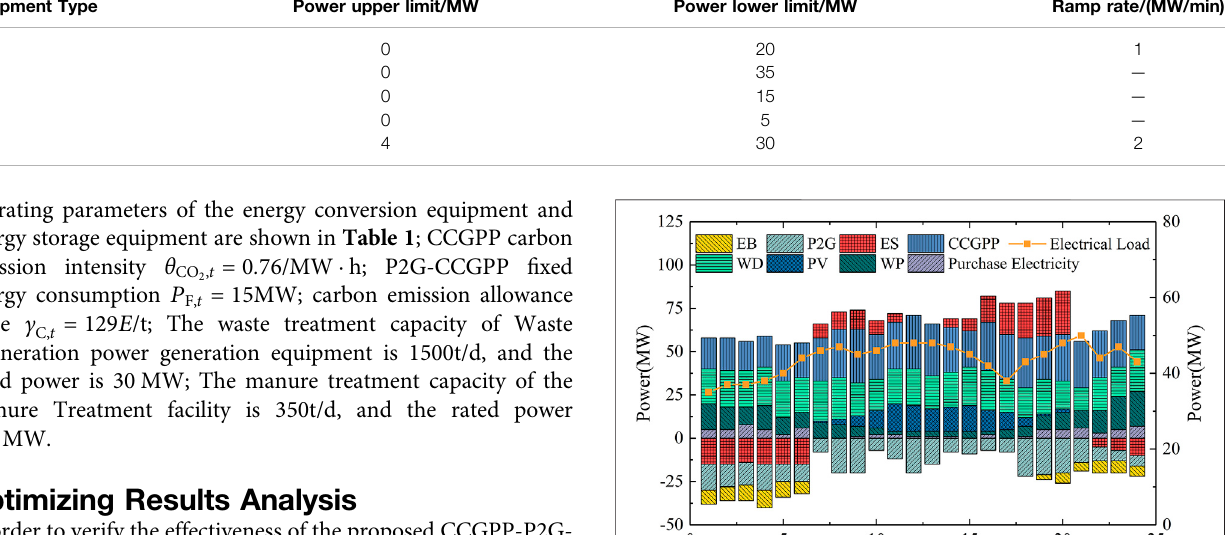
TABLE 1 | Operating parameters of energy conversion equipment and energy storage equipment. Equipment Type